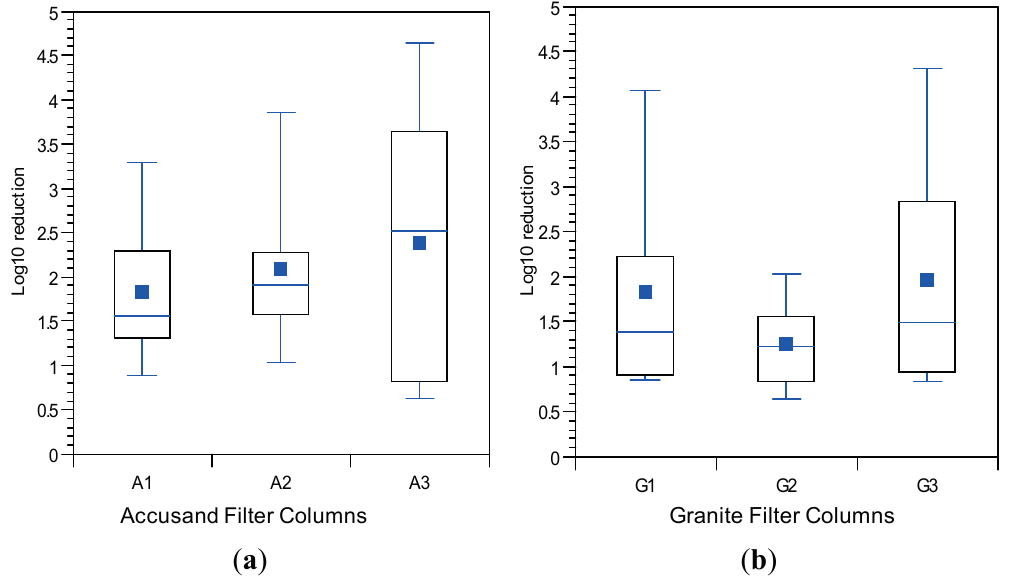
Figure 6. E. coli reductions for ( a ) Accusand-filled columns; and ( b ) granite-filled columns in Column Test No. 1 for samples collected throughout the eight-week experiment. N = 10 for G3; 11 for A1, A2 and G1; 12 for A3; 13 for G2.